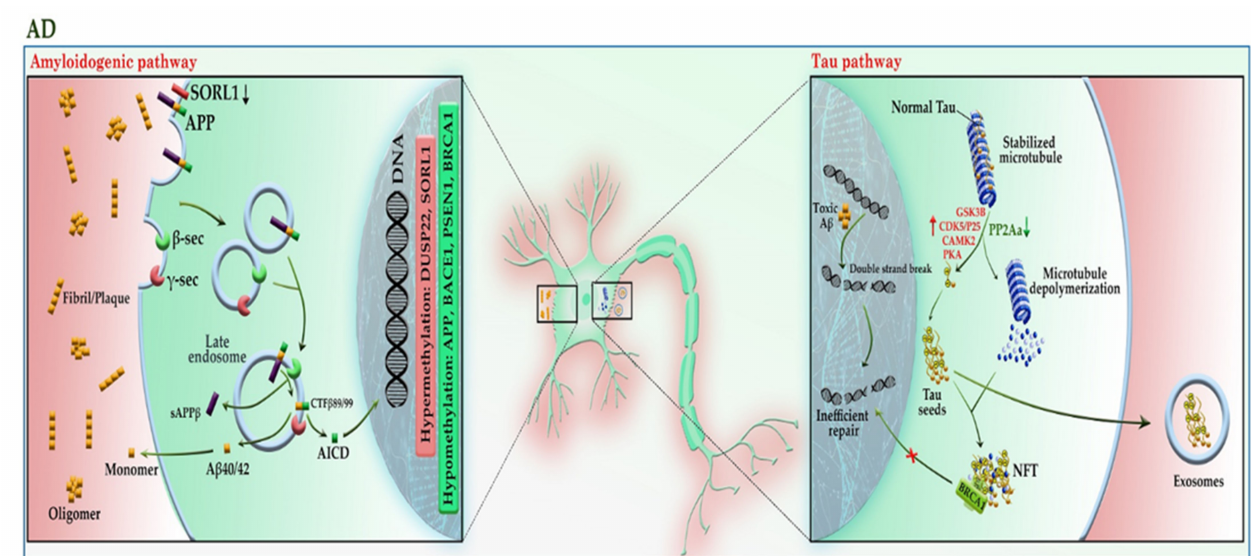
Figure 4. A schematic representation of the selected mechanisms in the pathogenesis of AD. Under physiological conditions, APP is cleaved in the non-amyloidogenic pathway (not shown). In the absence of SORL1 due to epigenetic silencing or mutation, APP is shunted into the late endosomal pathway. In the amyloidogenic pathway, APP enters the late endosome, where it is cleaved by the β - secretase (BACE1), and then by γ -secretase. AICD enters the nucleus and acts as a transcription factor, whereas the A β 40/42 peptides and sAPP β are secreted to the extracellular space. An imbalance of A β production and its clearance from the brain promotes A β aggregation and deposition. The A β aggregates can activate the kinases involved in the tau pathway, leading to tau hyperphosphorylation. The aberrant hyperphosphorylation of tau causes p-tau to be separated from microtubules (MTs), leading to MTs depolymerization and axonal degeneration. The disruption of the tau pathway leads to the accumulation of tau aggregates to form oligomers and neurofibrillary tangles (NFTs) within neurons. The p-tau oligomers (tau seeds) can be released into the extracellular space and taken up by unaffected neurons. The tau aggregates sequester BRCA1 protein in the cytoplasm and prevent it from executing its physiological function, leading to the accumulation of DNA damage induced by A β . Red and green colors highlighted hypermethylation and hypomethylation, respectively. AICD: amyloid precursor protein (APP) intracellular domain; APP: amyloid precursor protein; BRCA1: breast